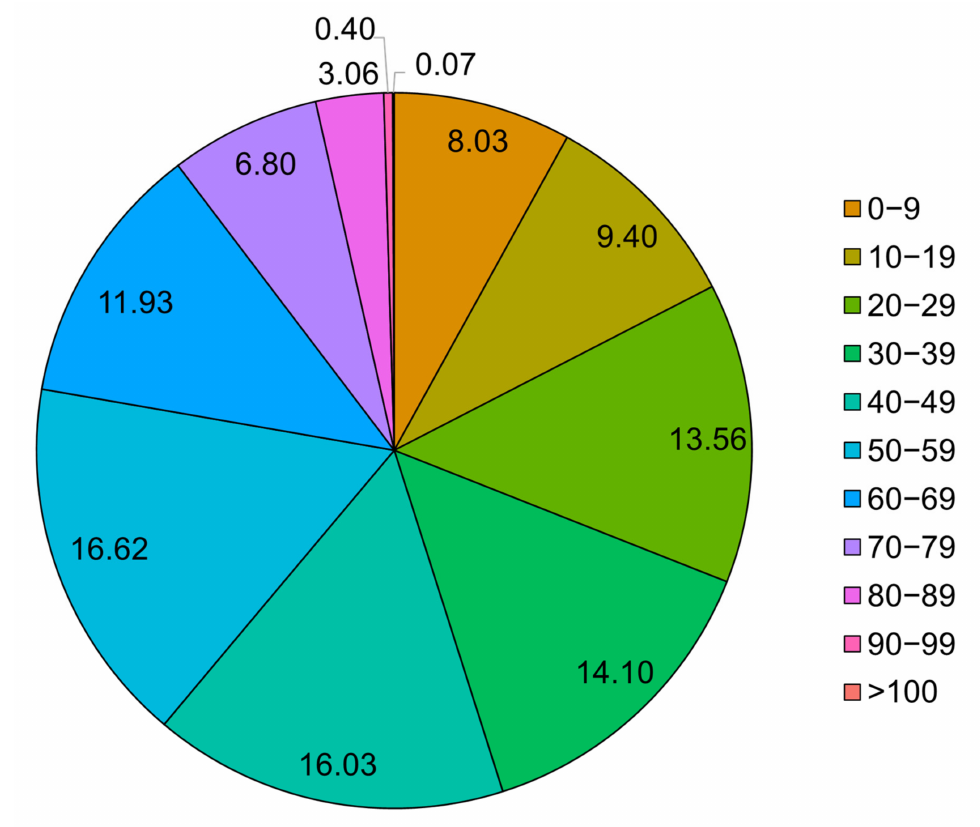
Figure 3. Pie chart of the percentage of each age group in the South Korean